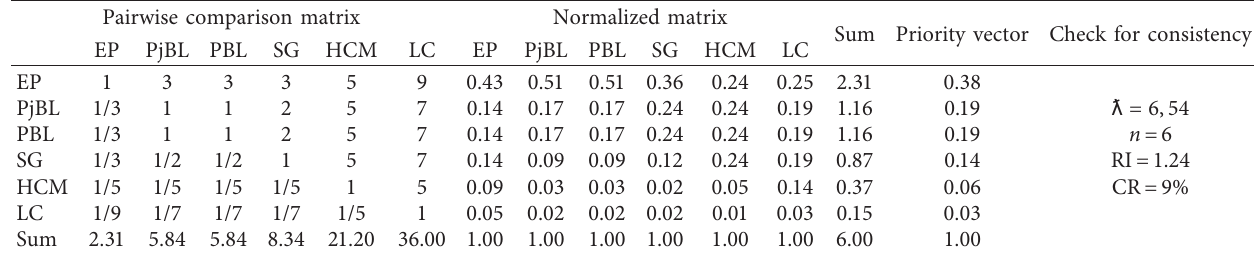
Table 14: Pairwise comparison matrix of learning strategies with respect to the Criterion “SS6. Autonomy and decision-making.” Pairwise comparison matrix Normalized matrix